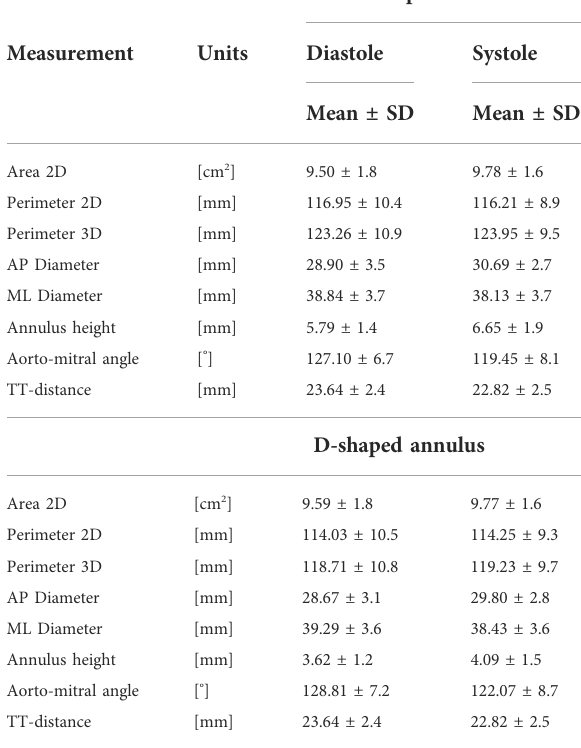
TABLE 1 Mitral annulus